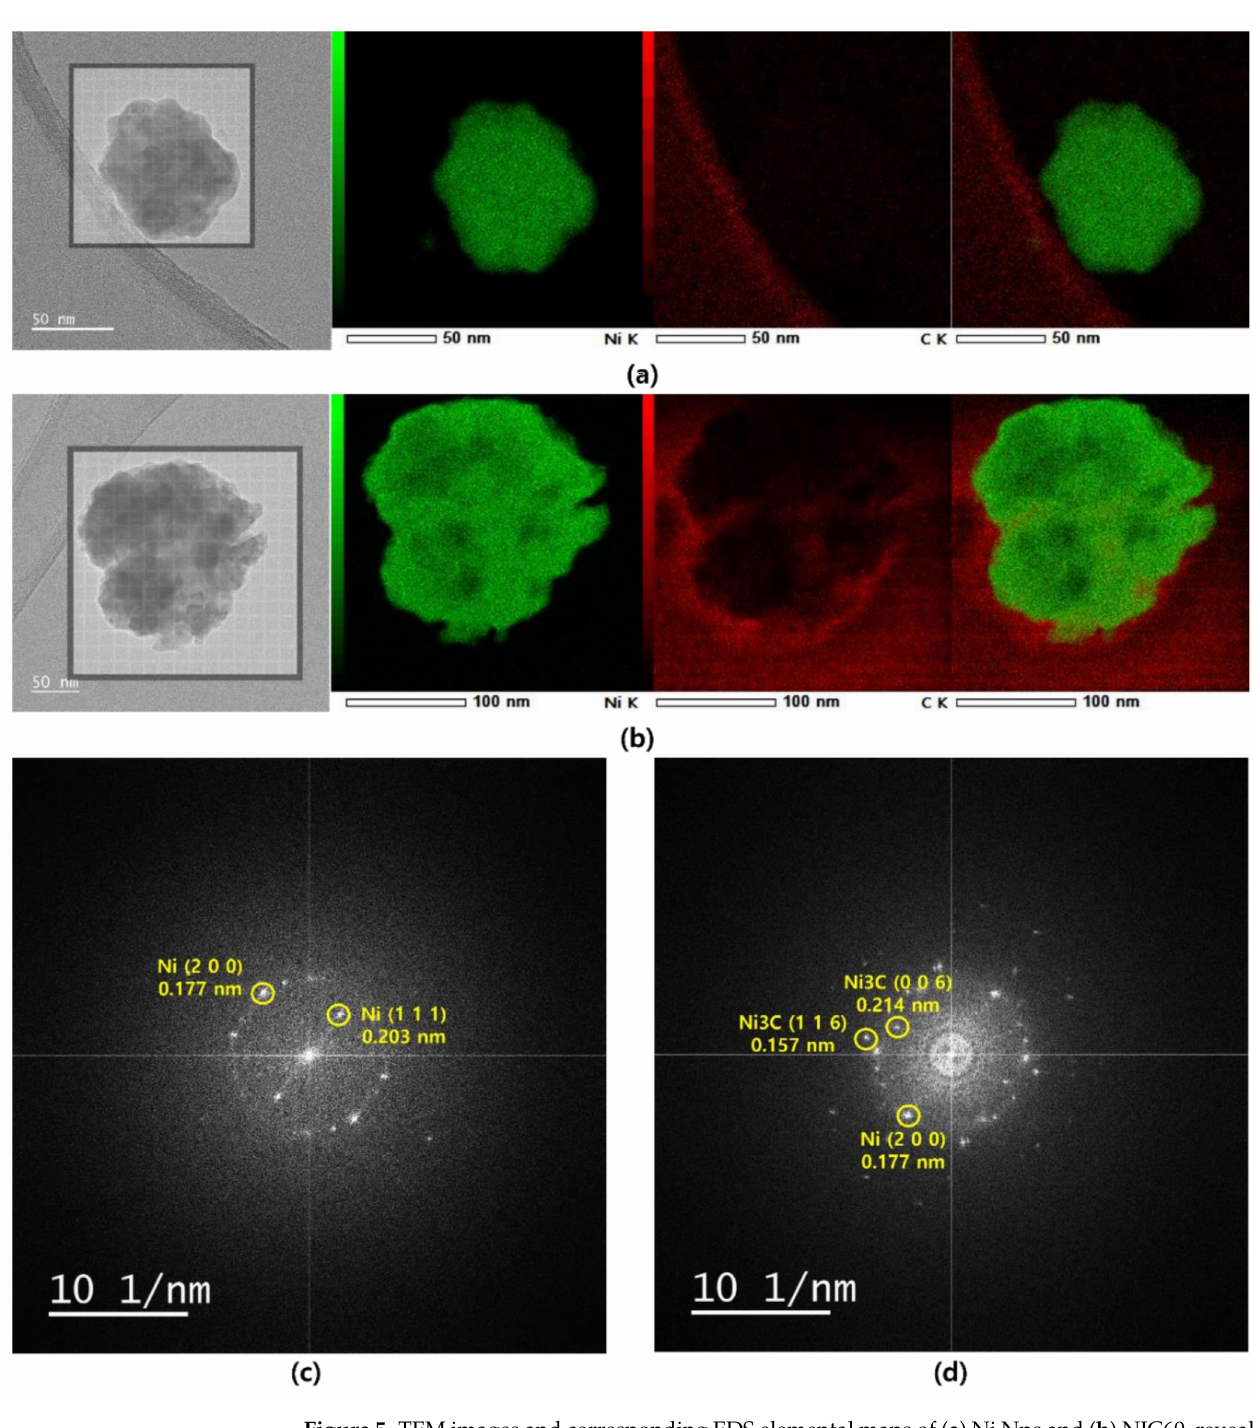
Figure 5. TEM images and corresponding EDS elemental maps of ( a ) Ni Nps and ( b ) NIC60, revealing the spatial distribution of Ni and C elements. ( c ) Fast Fourier transform (FFT) of Ni Nps. ( d ) Fast Fourier transform (FFT) of